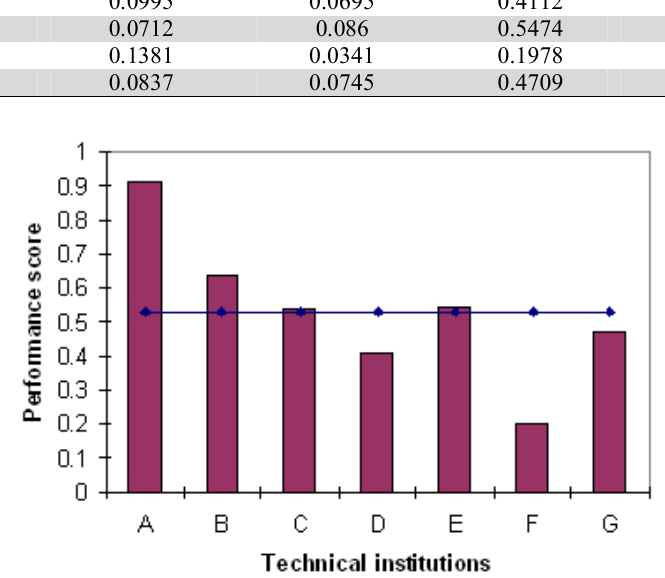
Fig. 6. Graphical view of overall performance score of the